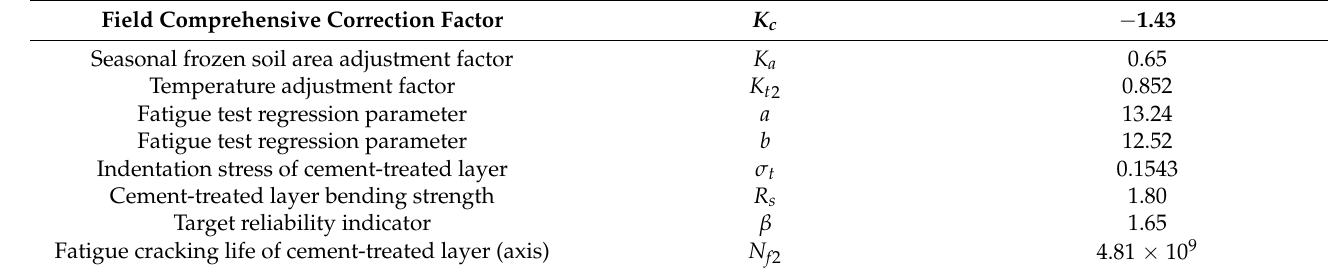
Table 22 lists the parameters required to calculate the fatigue life model. Table 22. Fatigue life model parameters of cement-treated